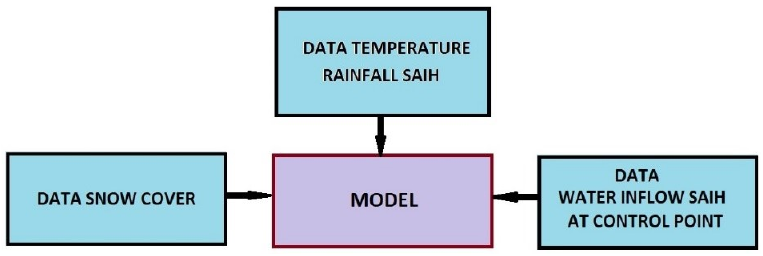
Figure 4. Calibration of the ASTER model with data from the SAIH network control points.